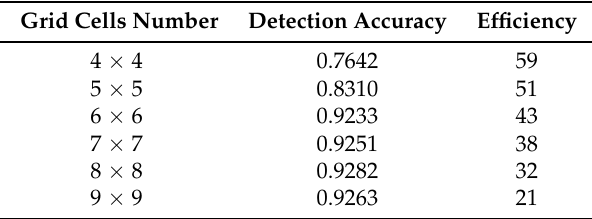
Table 4. Grid cells number test for DNet.